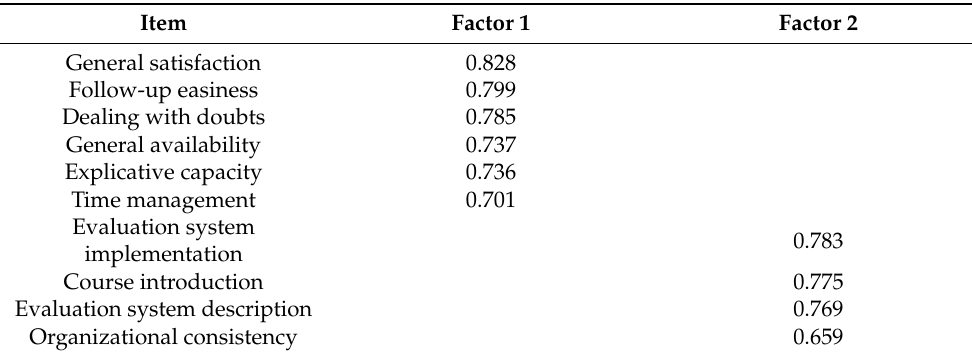
Table 2. Rotated component matrix.